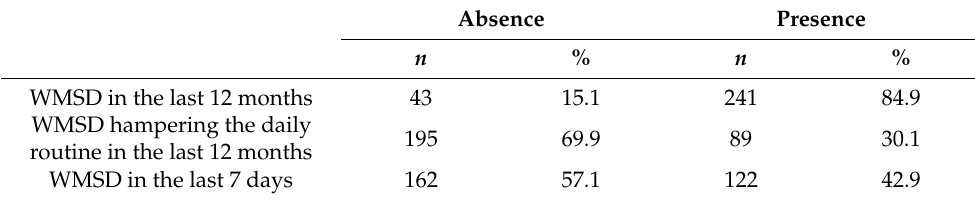
Table 1. Work-related musculoskeletal disorders (WMSD) prevalence in surveyed operators (ex- pressed as n and %). A high number of dental professionals (241/284) suffered from WMSD in the last 12 months. Of these, 89 operators experienced WMSD that interfere to perform daily routine in the last 12 months.